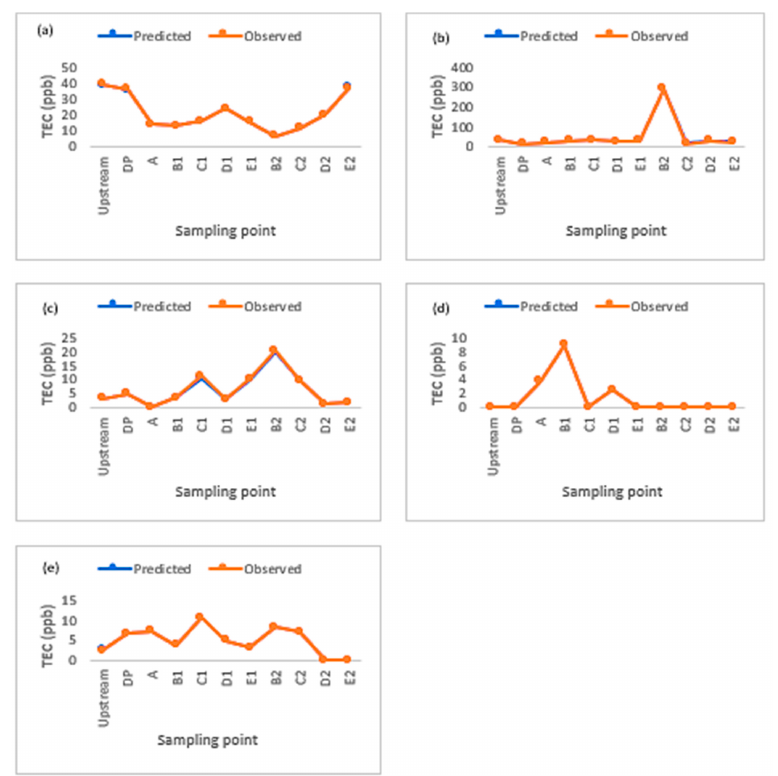
Figure 15. Series of observed and predicted TEC values ( a ) November, ( b ) December, ( c ) January, ( d ) February, and ( e ) March for the training phase in the wet season.